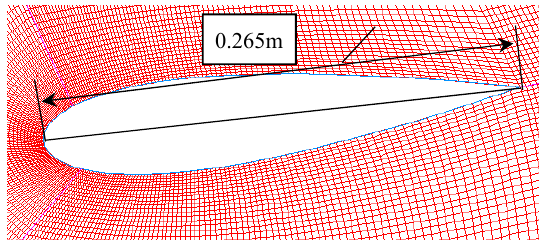
Figure 6. Mesh near blade.